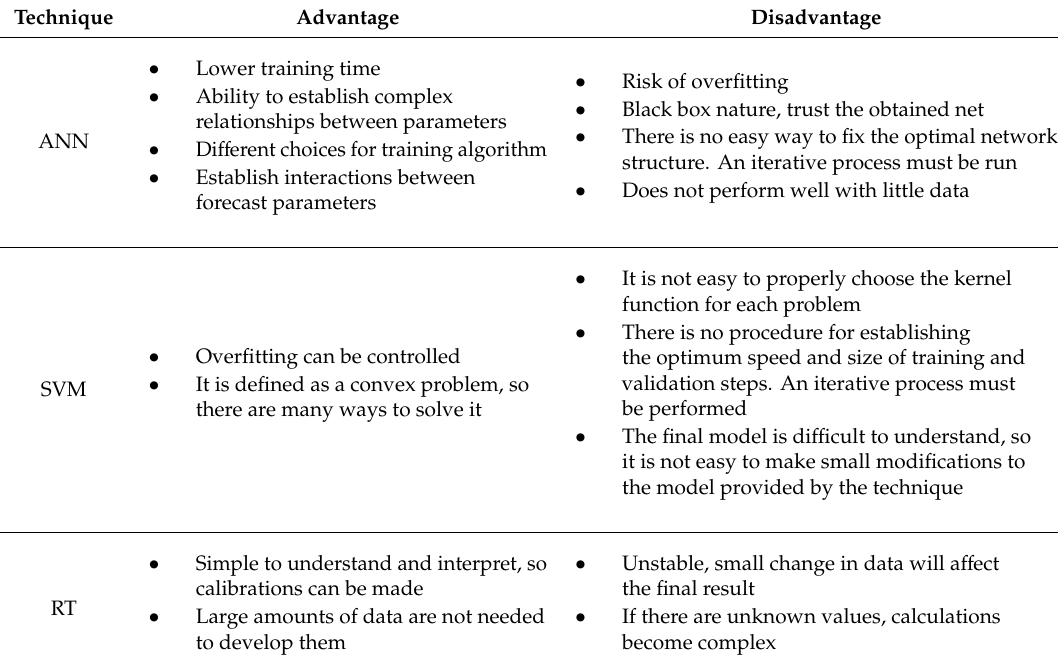
Table 1. Advantages and disadvantages of described non-parametric